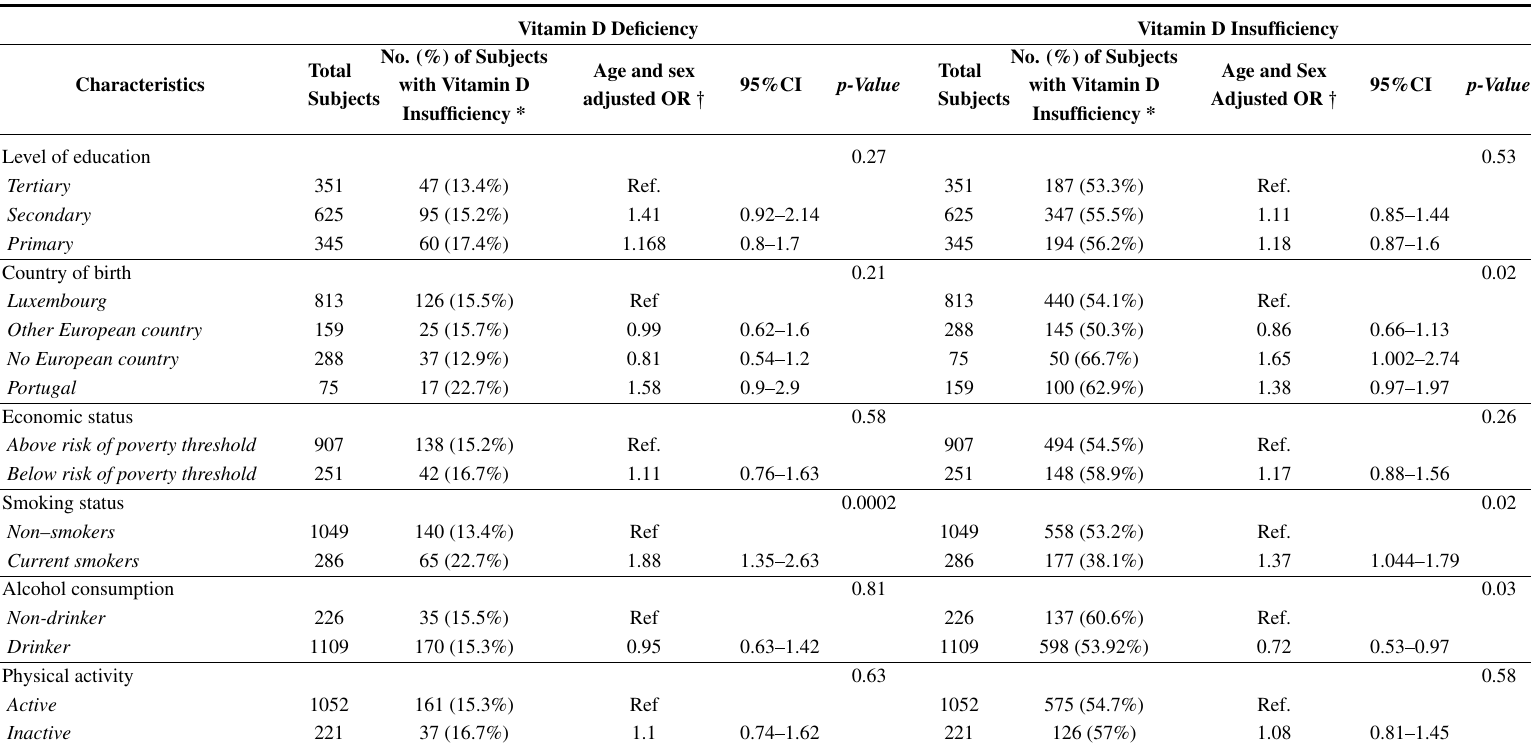
Table 1. Prevalence and age- and sex-adjusted odds ratios (ORs) for vitamin D deficiency and insufficiency by risk factors, in adults’ participants to the ORISCAV-LUX study ( n = 1335 subjects). Vitamin D